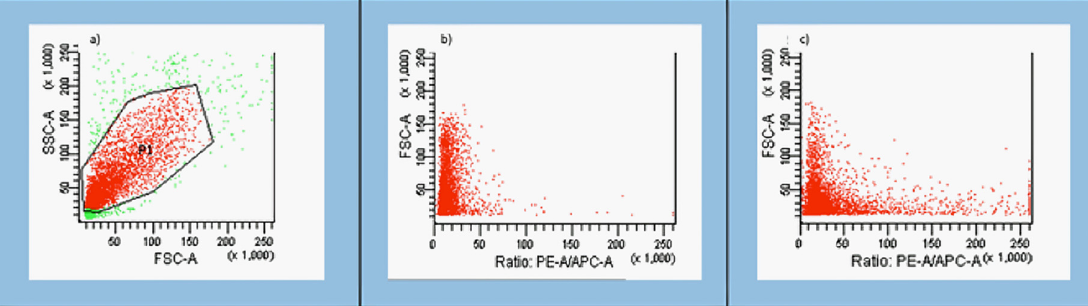
Figure 5. Evaluation of lipid peroxidation using BODIPY 665/676 C11. ( a ) Nasal epithelial cells were selected based on morphology and PI staining to exclude dead cells. ( b ) and ( c ) show the ratios of oxidised vs. reduced lipids.